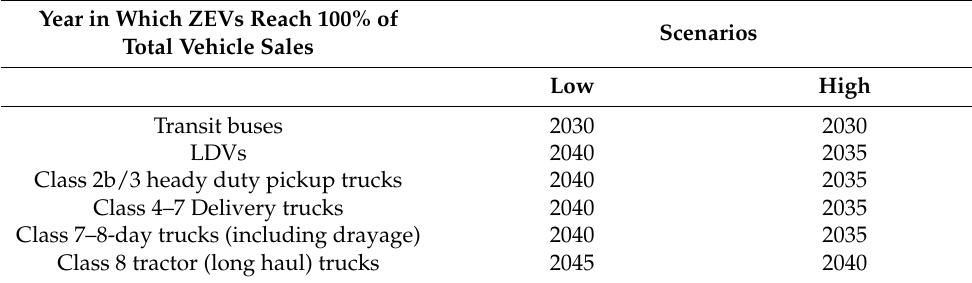
Table 1. 100% ZEV sales share with target years for high and low scenarios.